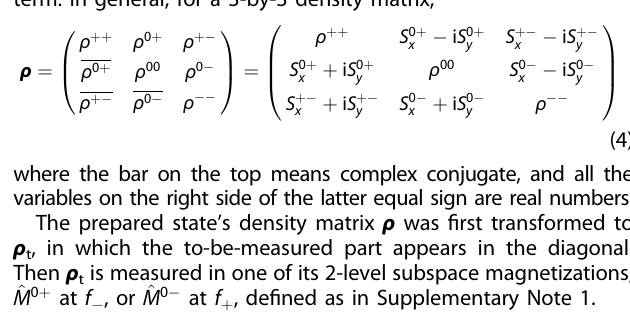
Fig. 1 (inset) with EasySpin (5.2.25) 39 , an isotropic g with g = 2.0037 and a D with j D j ¼ 152 MHz and j E j ¼ 50 : 4MHz are